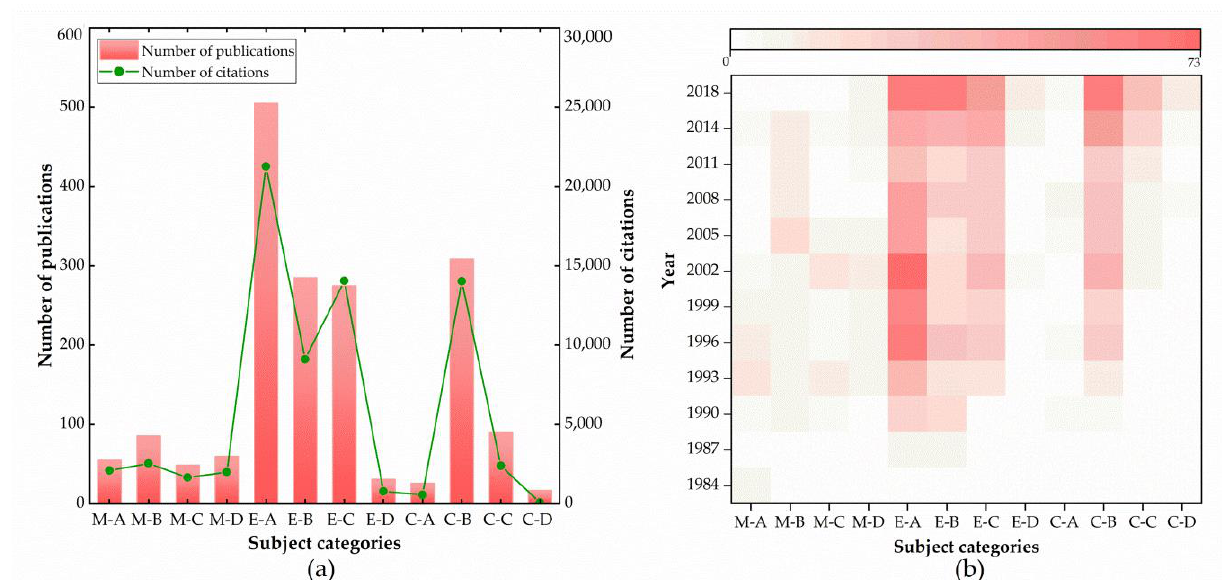
Figure 4. Subject Category analysis of the SBS. ( a ) Publications distribution; ( b ) Publications distribution over the years. (Note that M represents the category of Medicine, so M-A, M-B, M-C and M-D, respectively, represent the subject of Medicine Generalinteral, Toxicology, Allergy and Immunology; Similarly E represents Environment, so E-A, E-B, E-C and E-D respectively represent Public Environ- mental Occupational Health, Environmental Science, Engineering Environmental and Energy Fuels; C represents Engineering Construction, so C-A, C-B, C-C and C-D respectively represent Engineering Mechanical, Construction Building Technology, Engineering Civil and